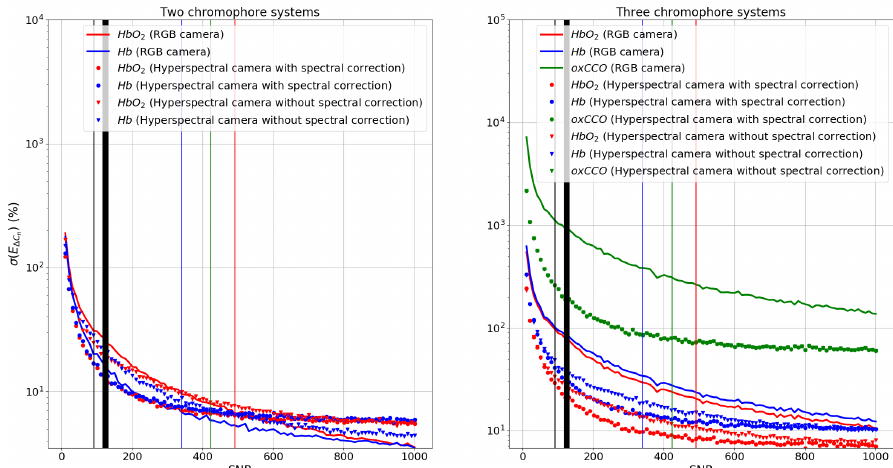
Figure 9. Standard deviation of the quantification errors in ∆ C HbO (red curves), ∆ C Hb (blue curves), 2 and ∆ C oxCCO (green curves) (see Equation (10)) obtained for the optimal spectral configuration of the hyperspectral camera (see Figure 7) and the RGB camera as a function of SNR. The solid lines were computed using the RGB camera; the curves with circles and with triangles were computed using the hyperspectral camera with and without spectral correction, respectively. Red, green, and blue vertical lines indicate the SNR values of the R, G, and B channels of the RGB camera and black vertical lines the SNR values of the spectral channels of the hyperspectral